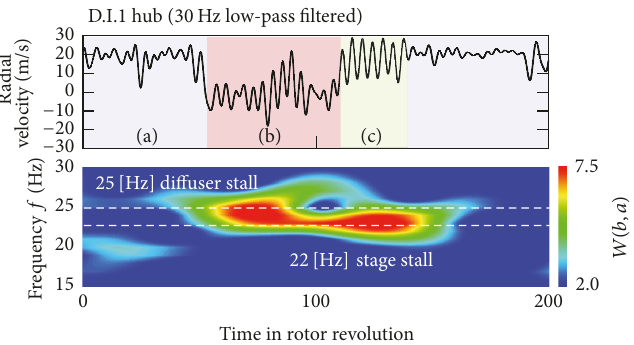
Figure 17: Contour map of the wavelet transform 𝑊(𝑎, 𝑏) for the low-pass filtered radial velocity traces on the hub